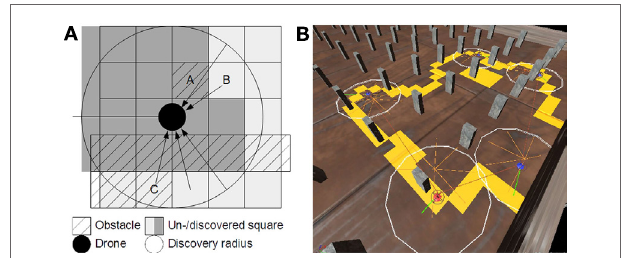
FigUre 10 | (a) The drone marks cells of a discretized environment grid to indicate scanned areas and determine its next steps. The done can mark unobstructed cells and unobstructed obstacles such as A but not occluded cells such as B and C. (B) The drones (blue boxes) are moving in different directions, maximizing their shared knowledge gain. Moving along they might get out of reach to synchronize. In this case, they need to move back to the “root” of the communication tree, i.e., the drone shown as the red